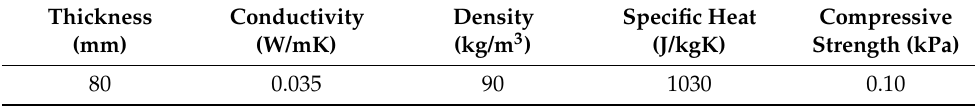
Table 6. Rock wool